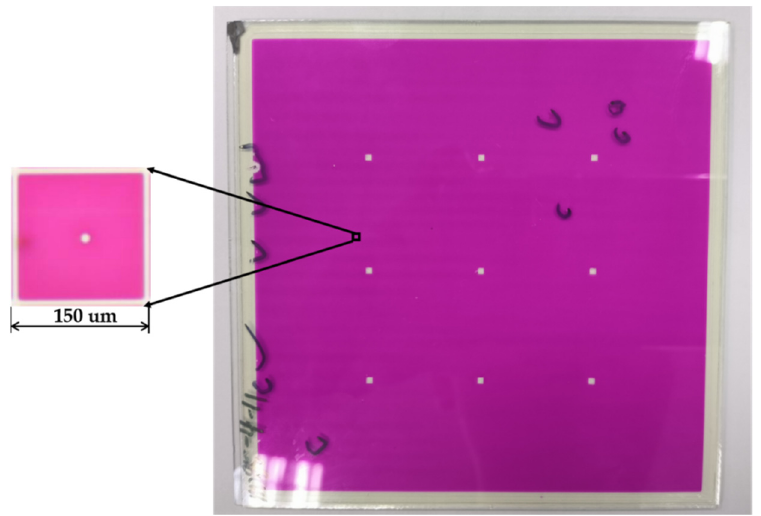
Figure 4. An EWD and a pixel. The pictures were taken by a mobile phone and a microscope. The EWD was used in our experiments.